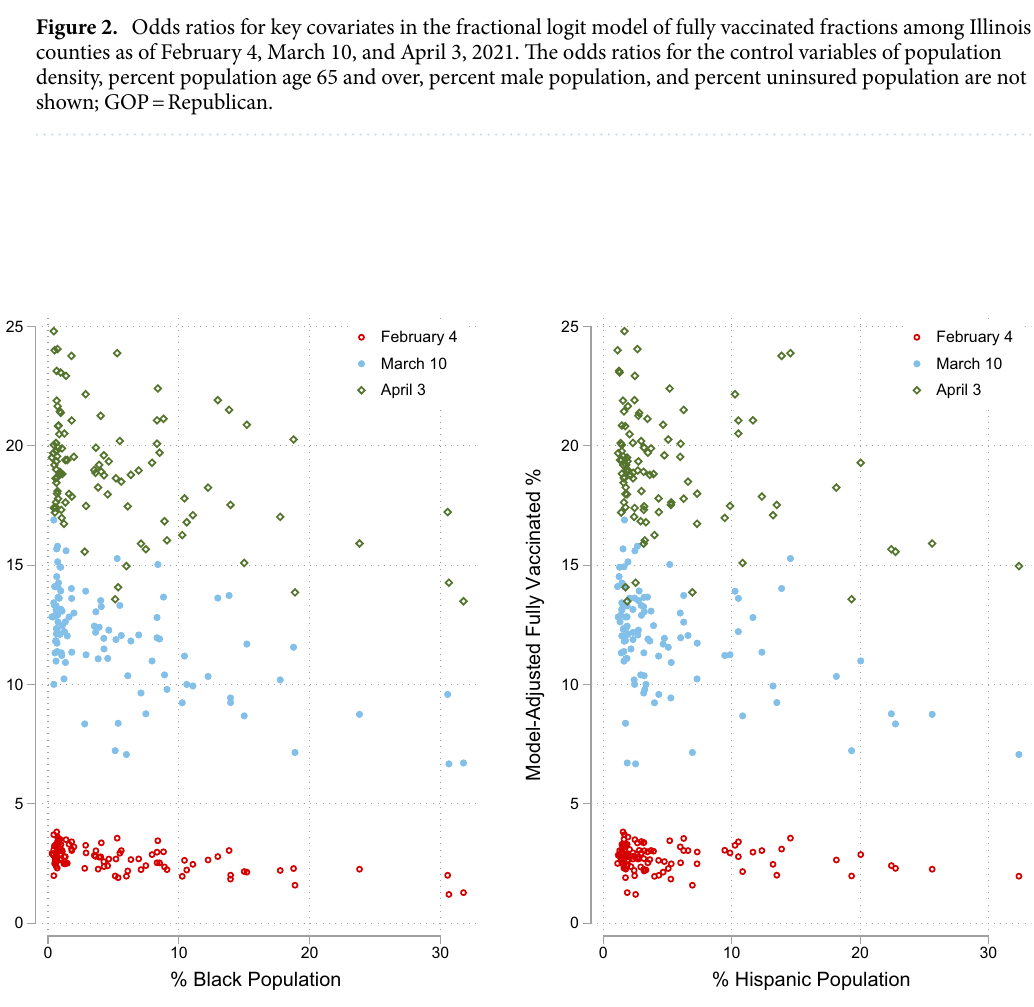
Figure 3. Model-adjusted fully vaccinated rates among the 51 Illinois counties with higher income inequality as of February 4, March 10, and April 3,